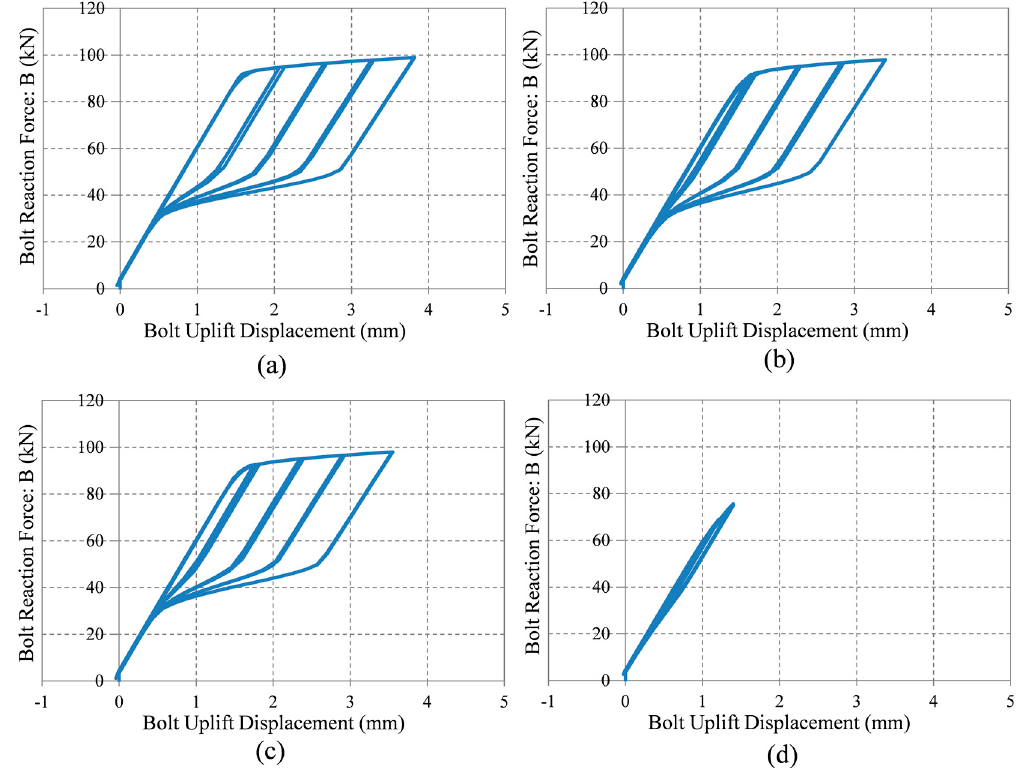
Figure 13. Average bolt reaction force and uplift displacement curves for four model cases: ( a ) Case-3; ( b ) Case-7; ( c ) Case-11; ( d ) Case-15.